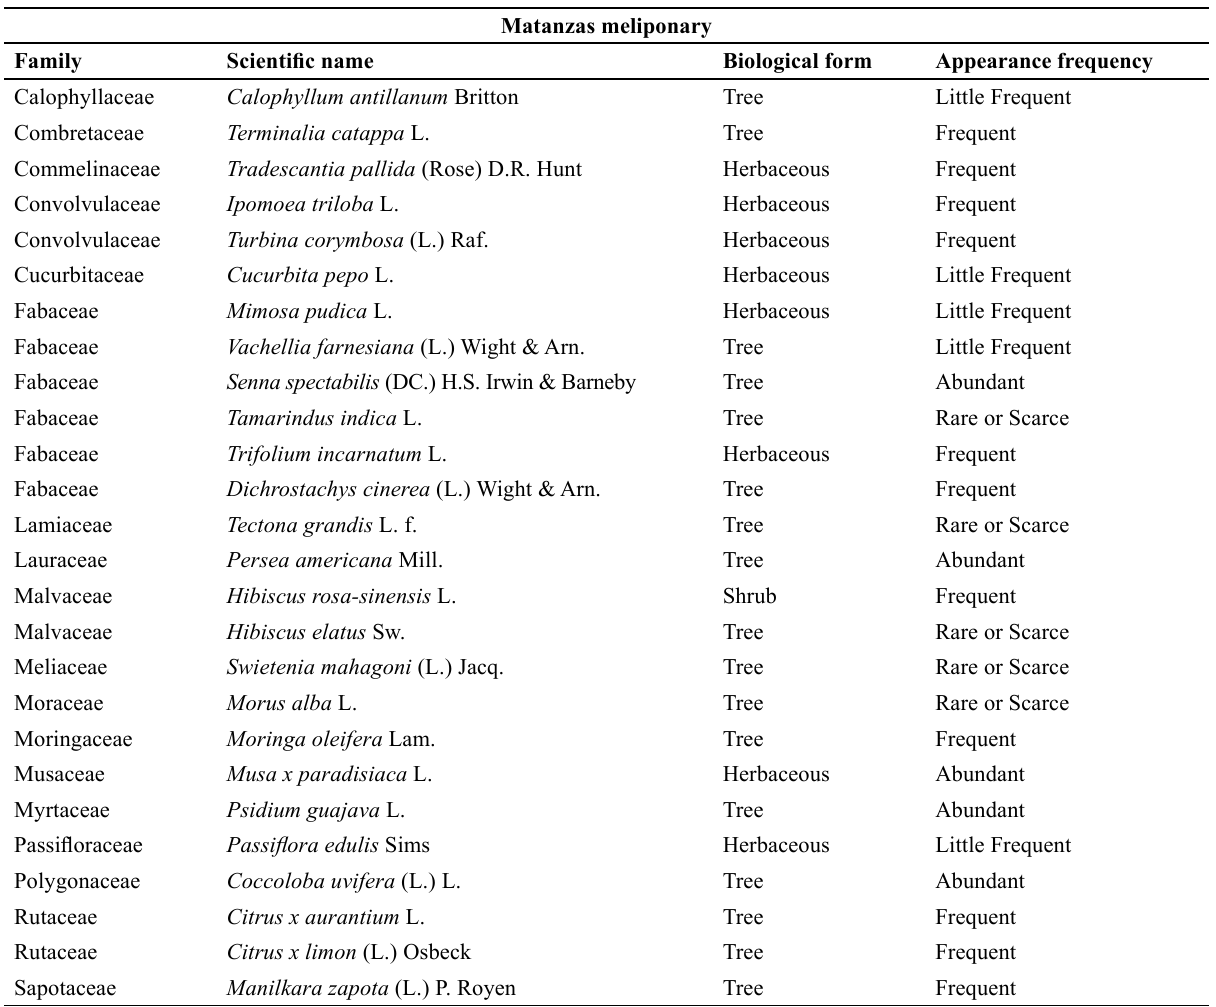
Table 1. Floristic inventory of the Matanzas locality, Cuba, 2018.